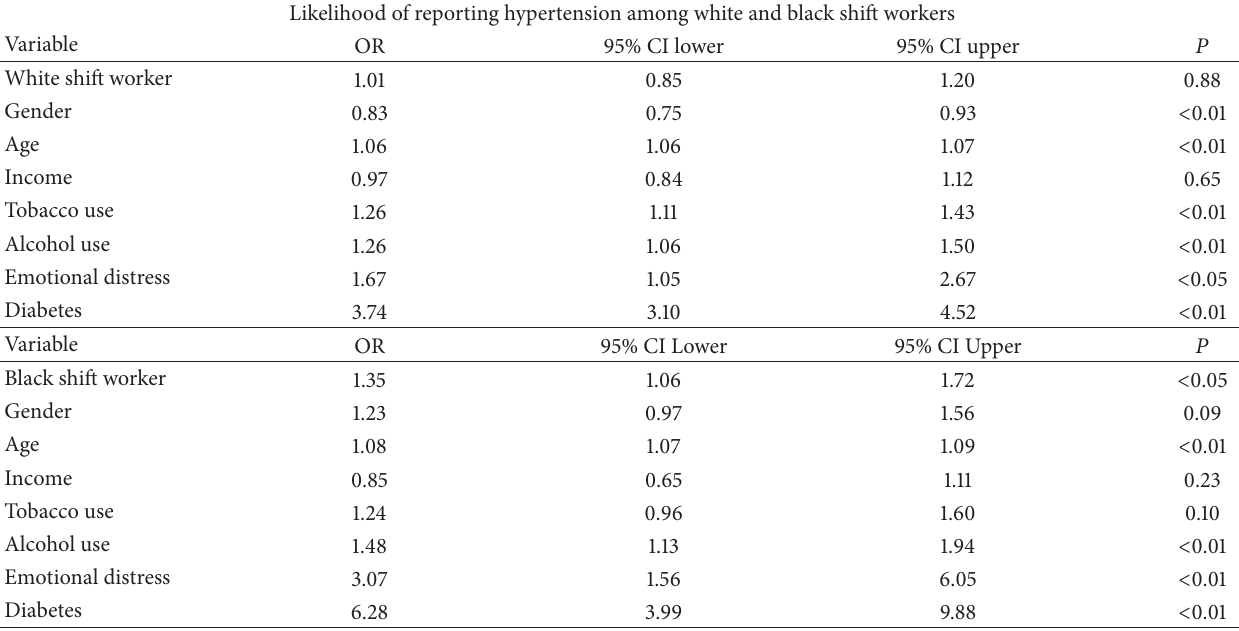
Table 3: Logistic regression analysis showing adjusted odds ratios (OR) and confidence intervals (CI) for hypertension among white (top pane) and black (bottom pane) shift workers.